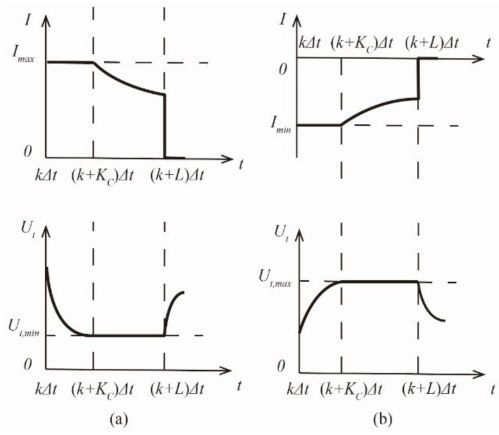
Figure 3. Battery current and terminal voltage in SOP estimation at a constant current constant voltage mode: ( a ) discharge; ( b )